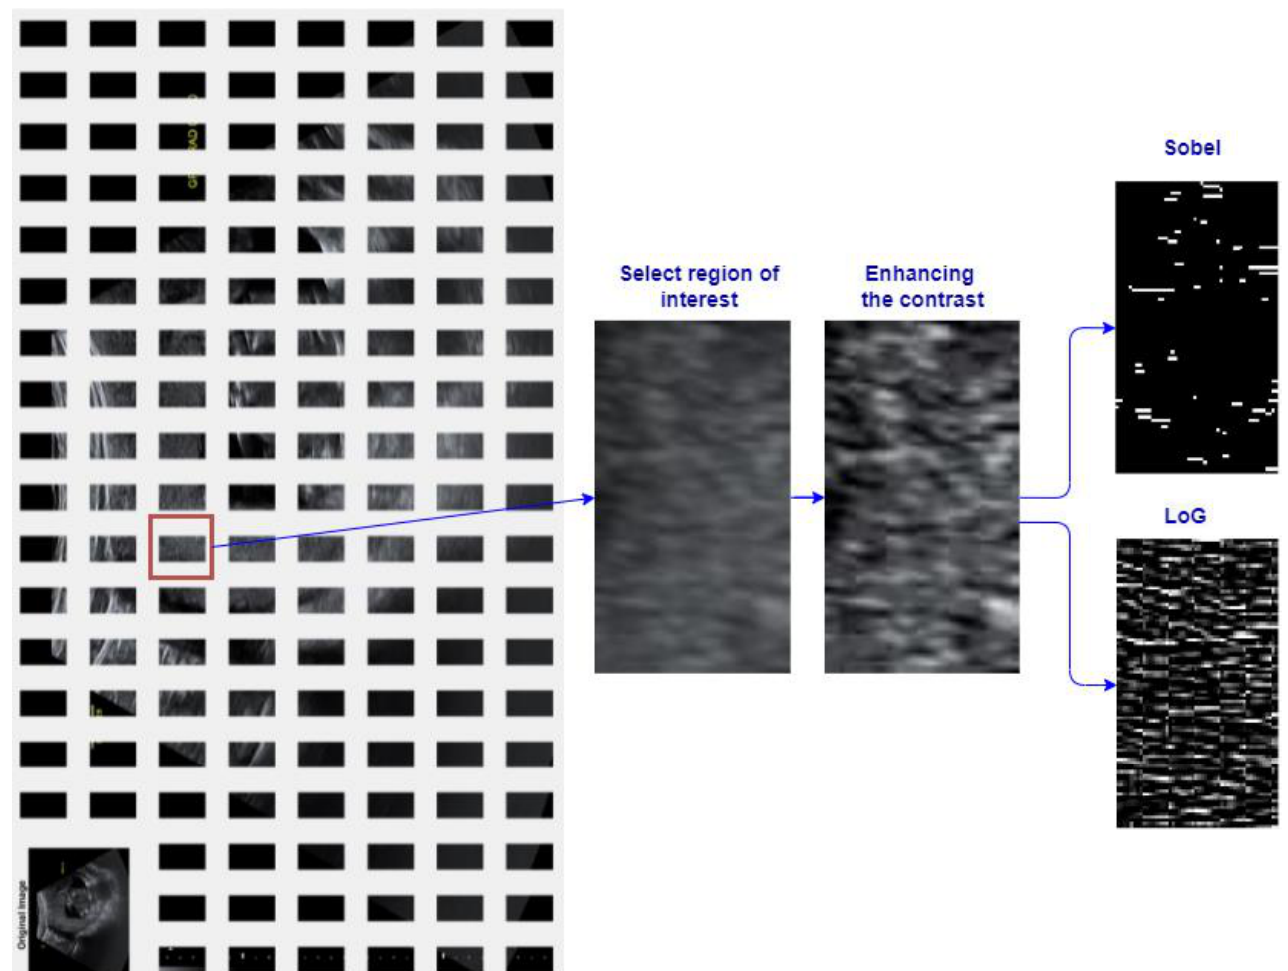
Figure 3. Illustration of regions of interest (ROI) and preprocessing operations for contrast and edge enhancement.